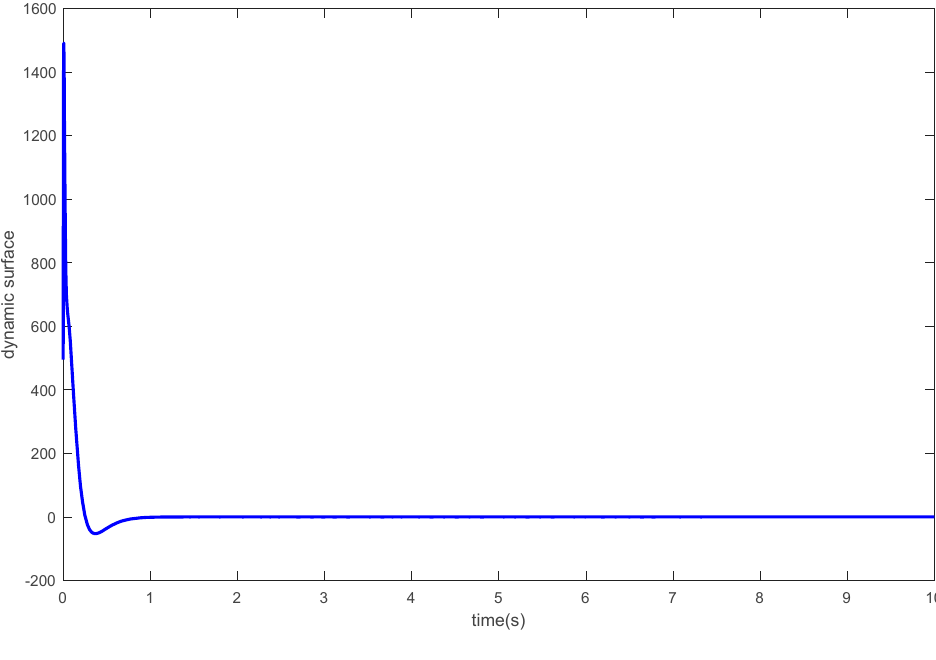
Figure 9. Time response of dynamic surface.